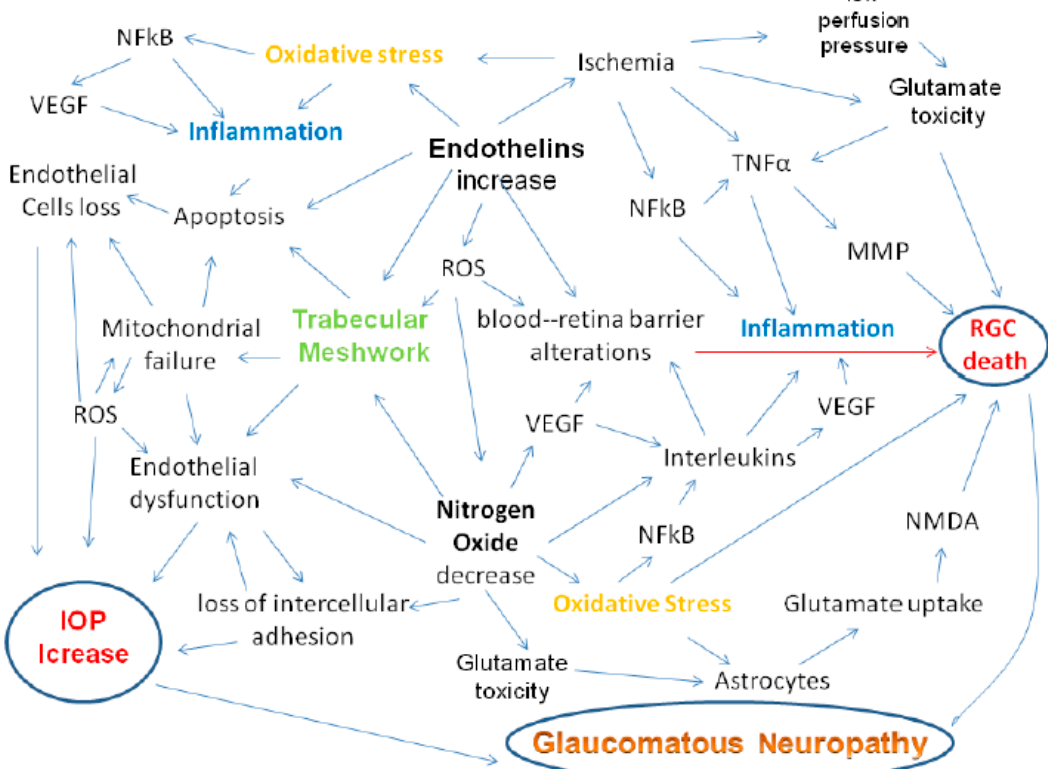
Figure 3. Inflammation due to oxidative stress is the basis both of alterations to the conventional outflow pathway, leading to IOP increase [13] and of the alterations that induce apoptosis of RGCs. Indeed, in glaucoma, the expression of inflammatory genes occurs. ROS also activate transcription factor NF-kB, which induces the expression of various agents, including pro-inflammatory cytokines (IL-1/6, TNF- α ) [90]. Pro-inflammatory cytokines, such as TNF- α or interleukins, are up-regulated, inducing intracellular and extracellular ROS production in human RPE cells [91]. Between oxidative stress and inflammation, NF-kB plays a strategic role, entering into the nucleus to induce transcription of a myriad of genes that mediate diverse cellular processes, such as immunity, inflammation, proliferation, apoptosis and cellular senescence [92].